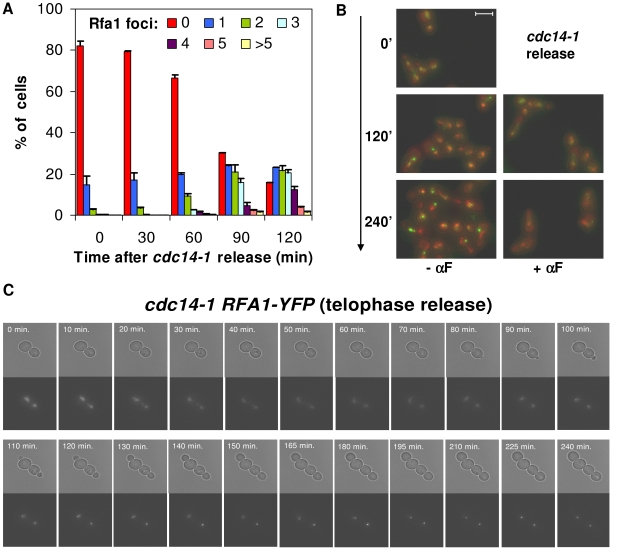
Cells coming from a cdc14-1 release form Rfa1 factories only after reaching S-phase.(A) Strain FM513 (cdc14-1 RFA1-YFP) was treated as in Figure 2. Samples were taken every 30′ after the release and Rfa1-YFP foci quantified per cell (mean ± SEM, n = 3). (B) Representative micrographs of FM513 cells at the telophase arrest (0′), 2 hours (120′) and 4 hours (240′) after the release into fresh medium with or without α-factor. Bright field photos are superimposed over the two fluorescent channels (red for DAPI and green for Rfa1-YFP). (C) Time-lapse fluorescence microscopy (every ∼10–15′ for 4 hours) of one FM513 cell starting at the time of the telophase release.